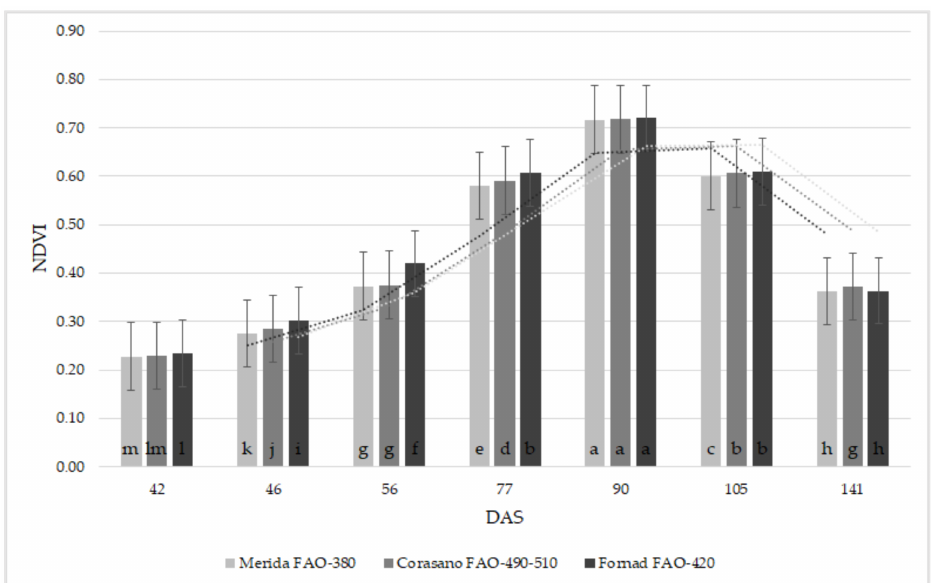
Figure 10. The NDVI UAV values of maize hybrids at different DAS (Debrecen, 2021); means of the varieties ± standard error. Differences between the examined hybrids at DAS were significant at the p = 0.001 level. Different letters indicate significant difference at the p < 0.05 level among the hybrids and DAS. LSD = 0.005. The correlation between the NDVI UAV values of the hybrids and the yield t ha − 1 varied due to the genotypes (different FAO), as is shown in Table